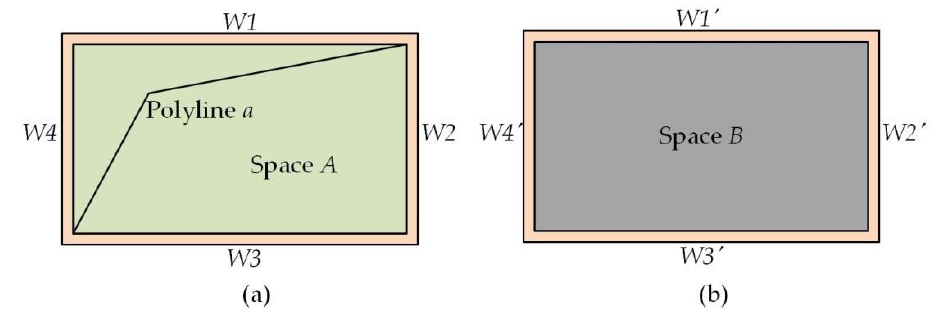
Figure 11. Judging the connectivity of building spaces: ( a ) cross-floor space and ( b ) single-floor space.